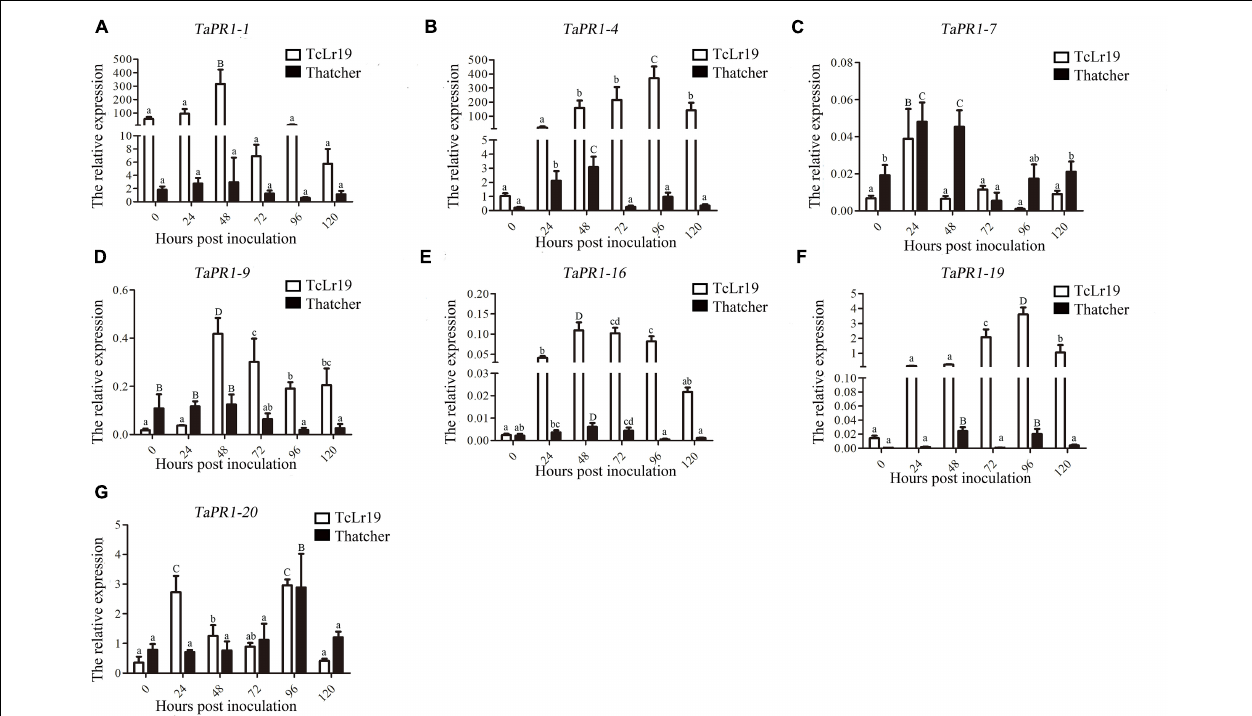
FIGURE 1 | The expression profiles of seven TaPR1 genes in incompatible and compatible interactions at different times post-inoculation. (A–G) Relative expression of TaPR1-1 , TaPR1-4 , TaPR1-7 , TaPR1-9 , TaPR1-16 , TaPR1-19 , and TaPR1-20 after inoculated with Pt is presented as fold change relative to mock-inoculated plants at 0 hpi. The y-axis indicates the amount of TaPR1 genes transcript normalized to the GAPDH gene. The x-axis indicates sampling time. Values are means ± SEM of three independent biological replicates. Significant differences were assessed using one-way analysis of variance (ANOVA) and Duncan’s multiple range test (DMRT) with p <